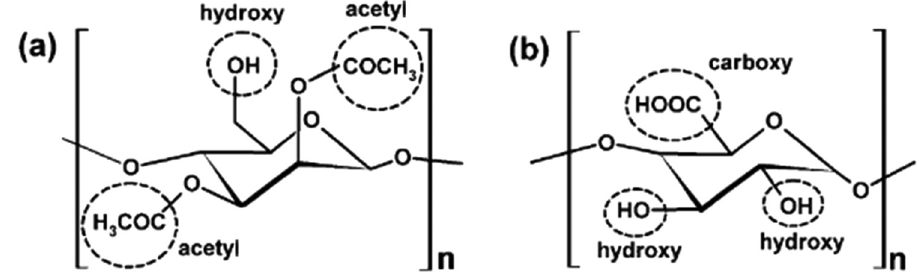
Figure 15: Schematic of n - repeating units of ( a ) acemannan and ( b ) pectin. The functional groups at the terminal of the n - repeated units for the respective polysaccharides are labeled [ 81 ] . Reproduced by permission of the PCCP